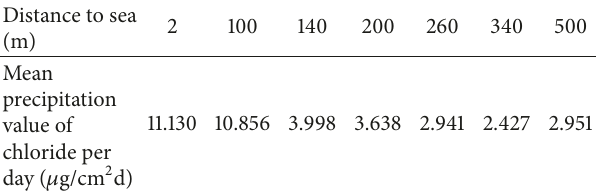
Table 1: The atmosphere chloride content of Zhoushan